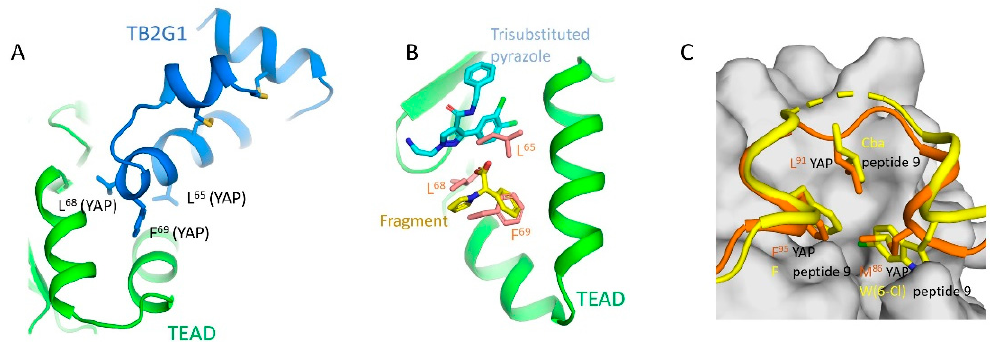
Figure 2. Modalities that occupy the surface pockets on TEADs ( A ) A model of the cystine-dense peptide (TB2G1) at the interface 2 pocket. The residues corresponding to the LxxLF motif of YAP is shown as sticks. ( B ) Crystal structures show that a fragment and the small molecule trisubstituted pyrazole occupy the interface 2 pocket on TEADs. Given the close proximity of the small molecule and the fragment, they could be linked to generate a potentially potent PPID. LxxLF residues of YAP is shown as salmon-colored sticks ( C ) Interface 3 region showing the omega-loop conformation of YAP (orange) (PDB ID: 3JUA) and peptide 9 (yellow) (PDB ID: 6Q36). The hydrophobic core residues in YAP and peptide 9 are shown as sticks and the interface 3 pocket on TEAD is shown in